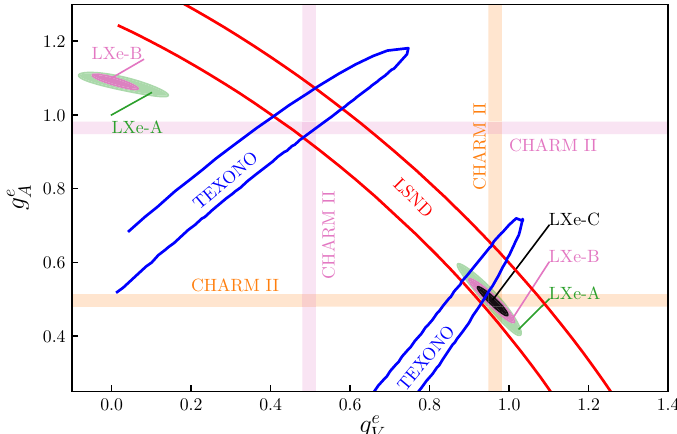
Figure 3 . Sensitivity of 51 Cr-LXe experiment to weak couplings parameters, g e to existing constraints. The solid blobs represent the expected constraints, centered on the SM values, for the LXe-A, LXe-B, and LXe-B configurations in this work. Prior constraints from TEXONO (blue) and LSND (red) are taken from figure 10.1 of PDG [60], and the CHARM II constraint comes from ref.